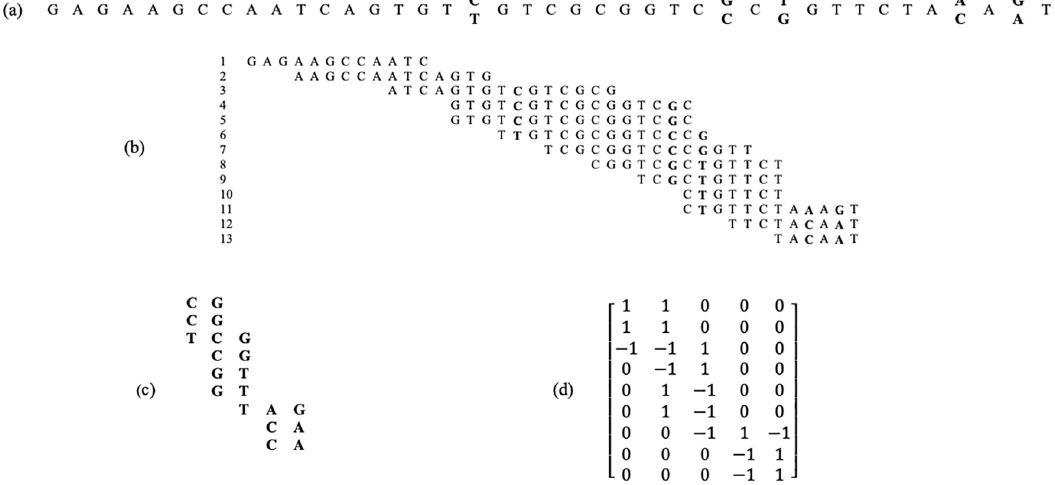
Fig 1. An example of fragment matrix model for the first 40 bases of exon 1 of HLA-A gene. This gene is located on chromosome 6 with NCBI reference sequence number NG_029217.2. It contains 5 bi-allelic SNP sites (refSNP): C/T (rs753601428), C/G (rs529070997), G/T (rs41560714), A/C (rs551138783) and A/G (rs778615037). a) An example of homologous chromosomes in which the SNP sites are indicated in bold, b) an example of aligned reads, c) the fragments after removing non-informative reads and non-SNP bases and d) the constructed fragment